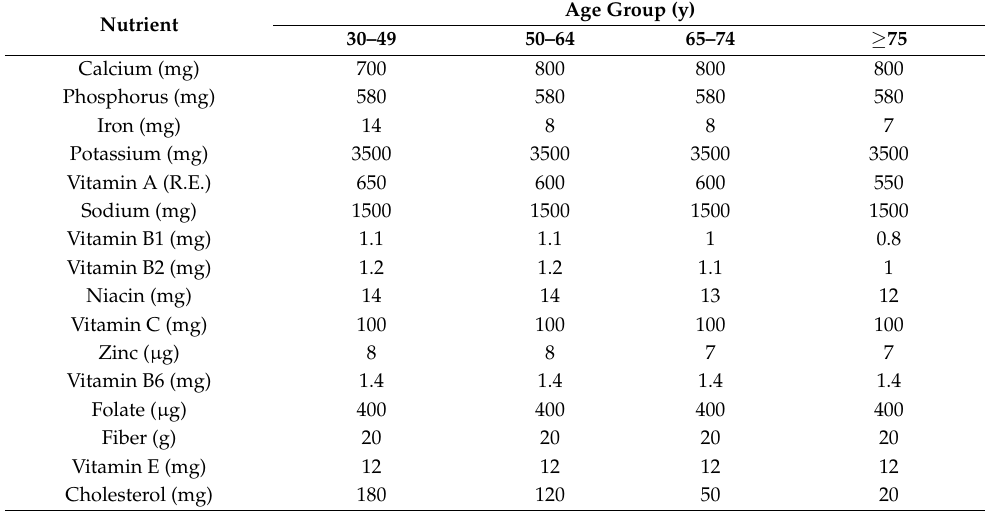
Table A1. Dietary reference intake levels for females in South Korean in 2020 according to age